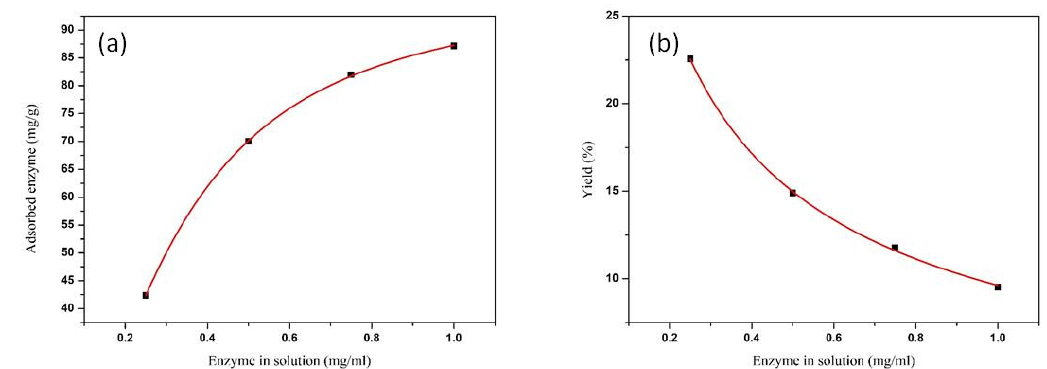
Figure 5. Adsorption isotherm (squares) and Langmuir fit (line) ( a ), and adsorption yield vs. the initial concentration of the enzyme in solution (squares) fitted with an exponential decay function (line) ( b ).